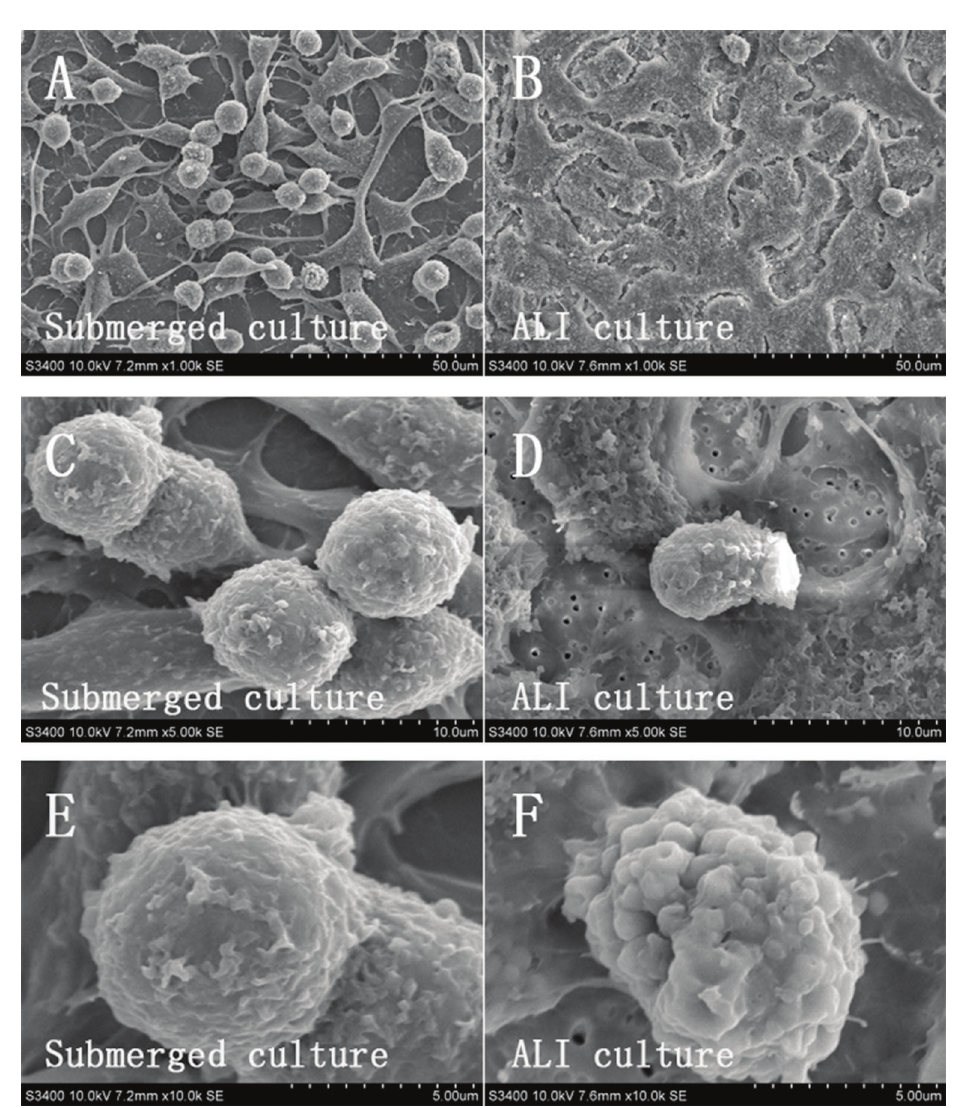
Figure 2. Scanning electronic microscopy (SEM) of air-liquid interface (ALI) of 2-week-old A549 ALI cultures and logarithmic phase of submerged cultures. A , C , and E , Different magni fi cations of submerged cultures showing a morphology of inerratic shapes with smooth surfaces; B , D , and F , different magni fi cations of ALI cultures exhibiting anomalous shapes and rough cell surfaces with abundant secretion on the surface of culture. Magni fi cation: A and B=50 m m; C and D=10 m m; E and F=5.0 m